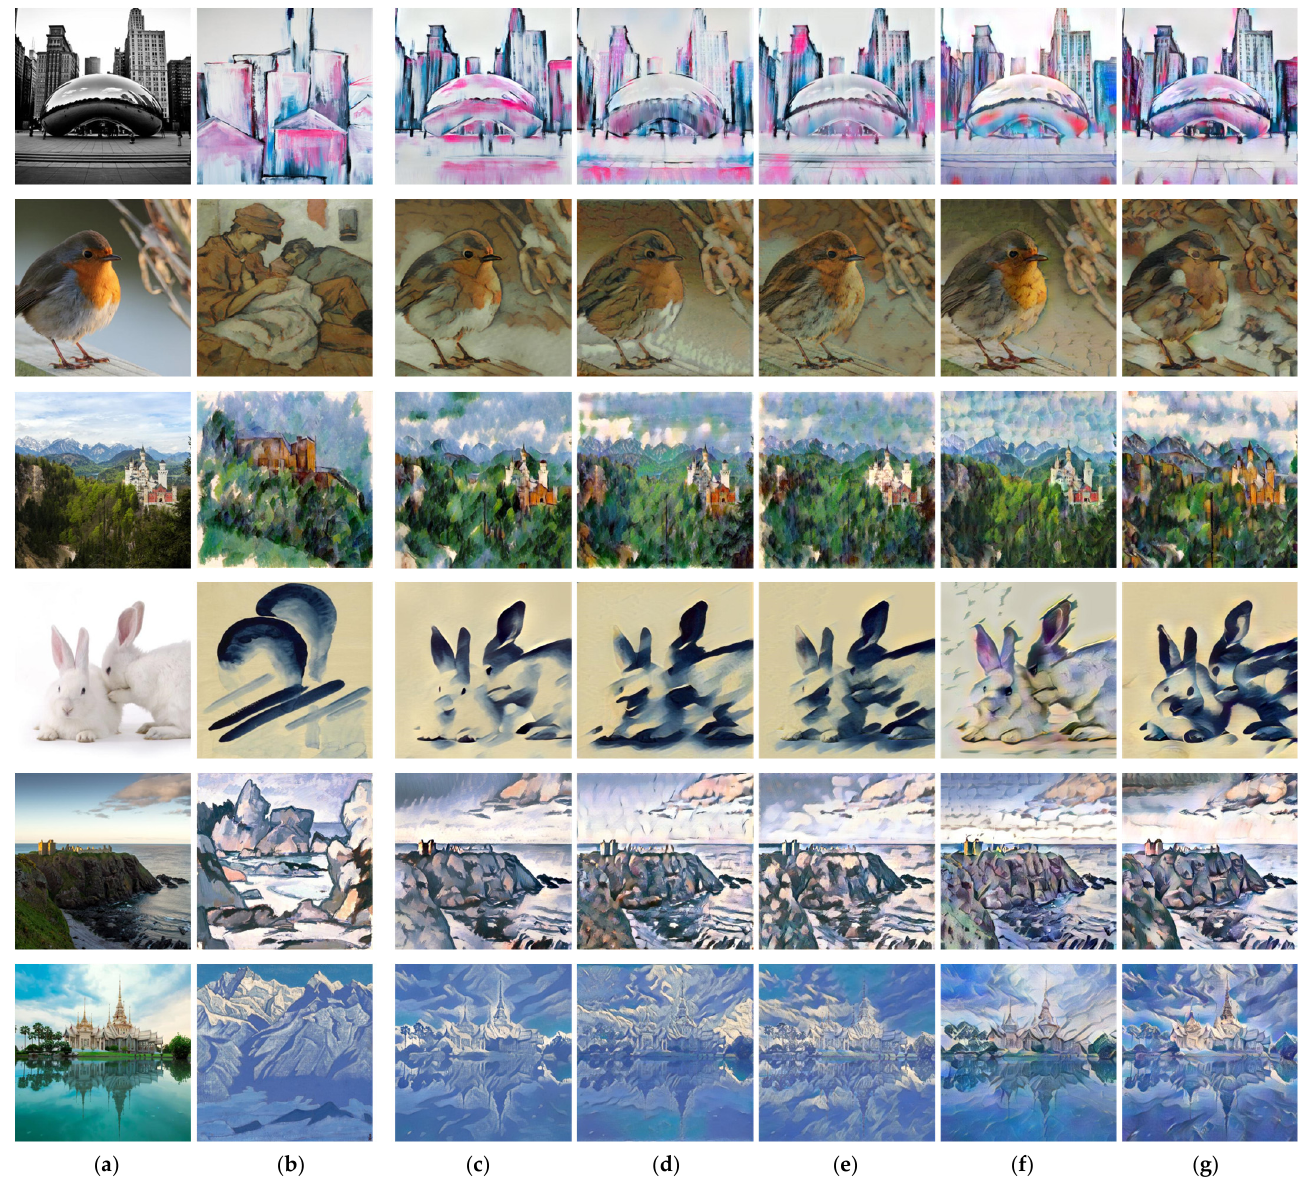
Figure 7. Qualitative comparisons between our method and other state-of-the-art methods: ( a ) The content images; ( b ) The style images; ( c ) The stylized images are generated by our method; ( d ) The stylized images are generated by Gatys et al. [1]; ( e ) The stylized images are generated by Johnson et al. [3]; ( f ) The stylized images are generated by AdaIN [5]; ( g ) The stylized images are generated by SANet